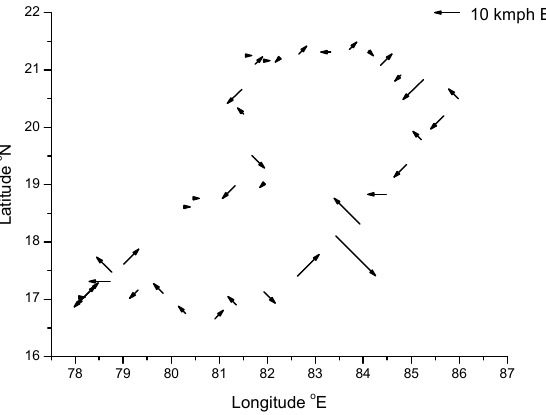
Fig. 3. Vector plot showing the wind speed and wind direction at the observing locations.